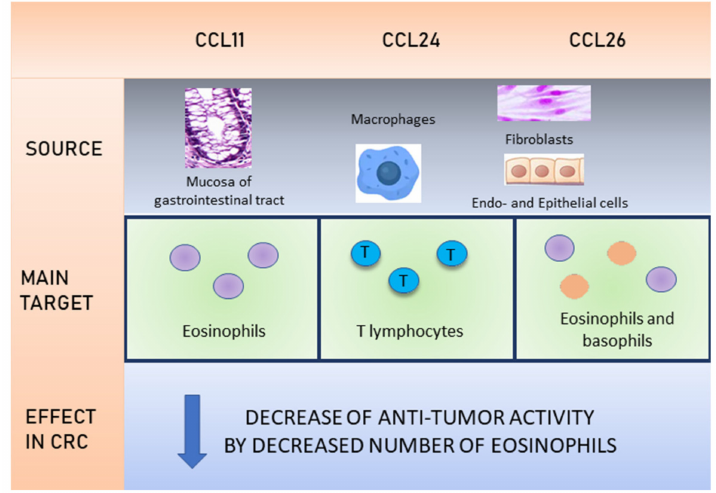
Figure 3. Eotaxins and their role in colorectal